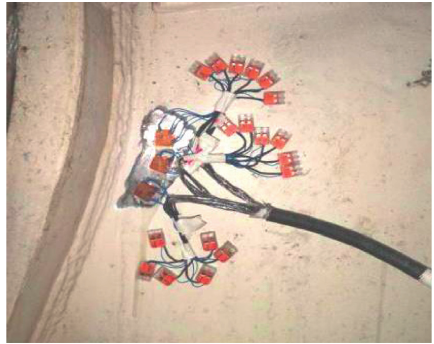
Figure 16: Strain rosette of measuring point.